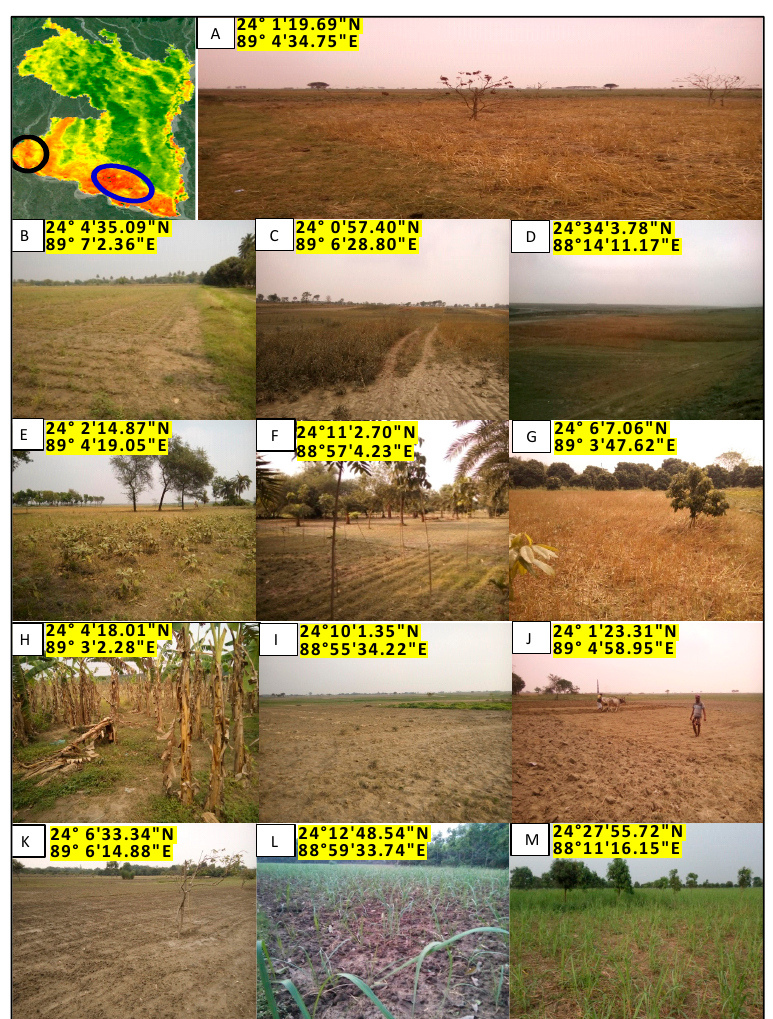
Figure 10. Field observations in the severe drought (highTVDI) area in the low Ganges River floodplain (GRFP) region.